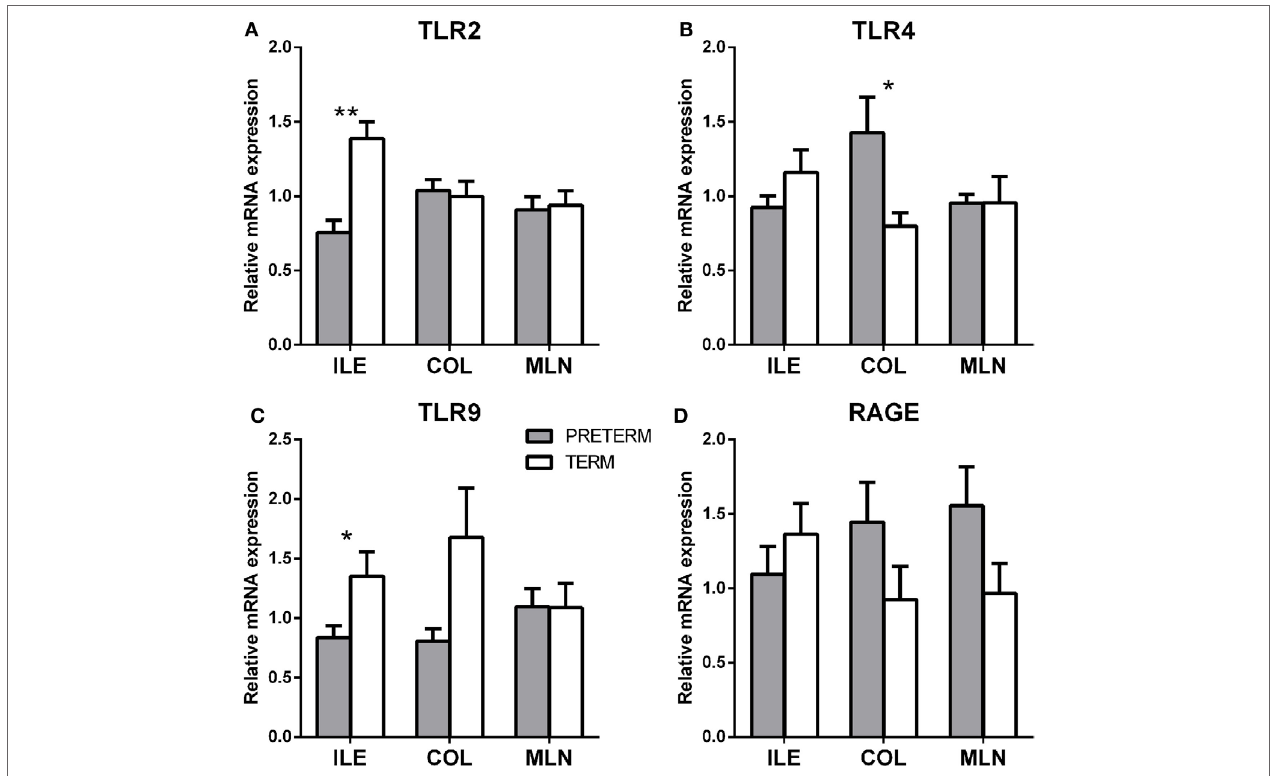
FigUre 5 | Transcription levels of pattern recognizing receptors TLR2, 4, 9, and RAGE in the intestine and mesenteric lymph nodes of the preterm and term germ-free piglets. Transcriptions of TLR2 (a) , TLR4 (B) , TLR9 (c) , and RAGE (D) were compared in the preterm ( n = 6, gray columns) and the term ( n = 6, white columns) germ-free piglets in the ileum, the colon, and the mesenteric lymph nodes. The results are presented as mean + SEM. The instances of statistical significance in the colon are denoted with asterisks (* P < 0.05 and ** P <